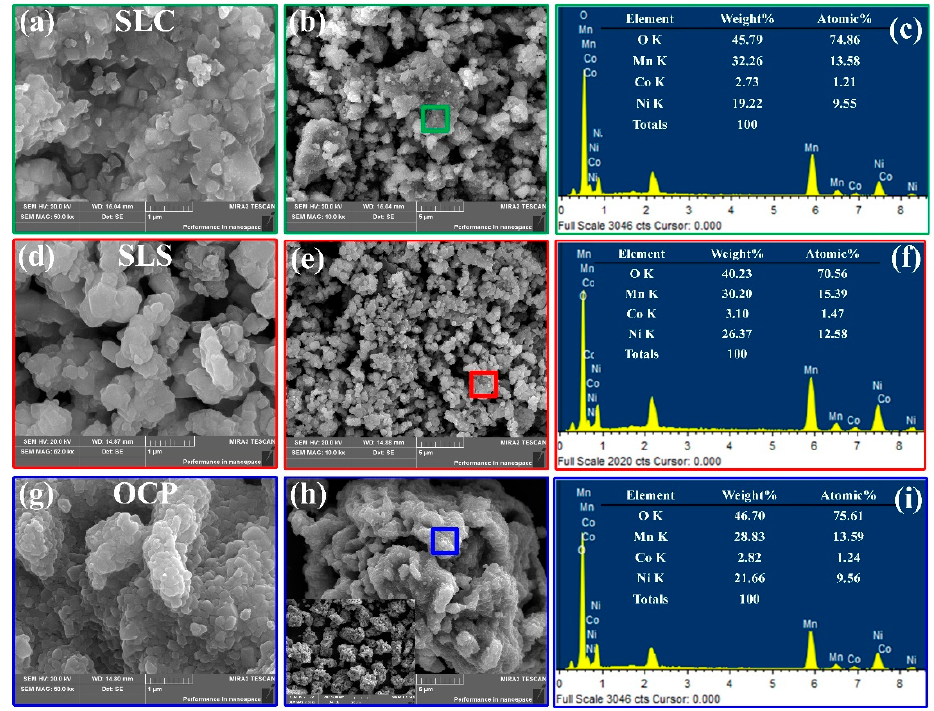
Figure 2. SEM images and energy dispersion spectra (EDS): ( a – c ) SLC; ( d – f ) SLS; ( g – i )